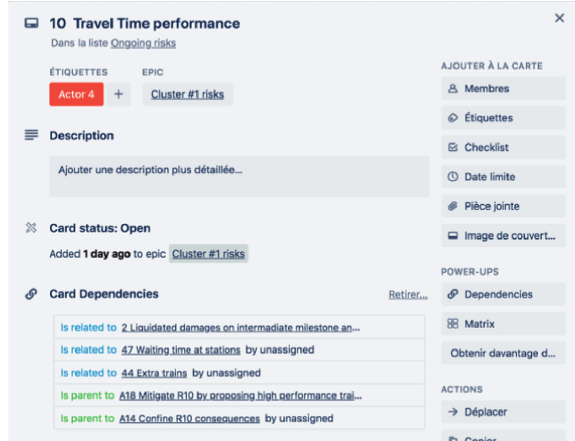
Figure 9: Status of a specific risk R